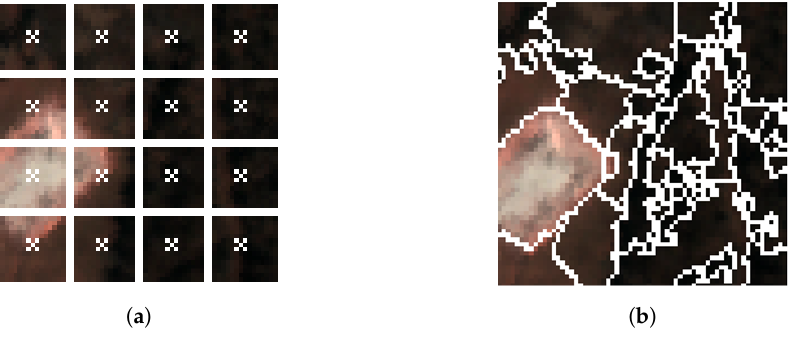
Figure 7. SLIC segmentation for region size initially set to 16 × 16: ( a ) initialization stage; ( b ) final